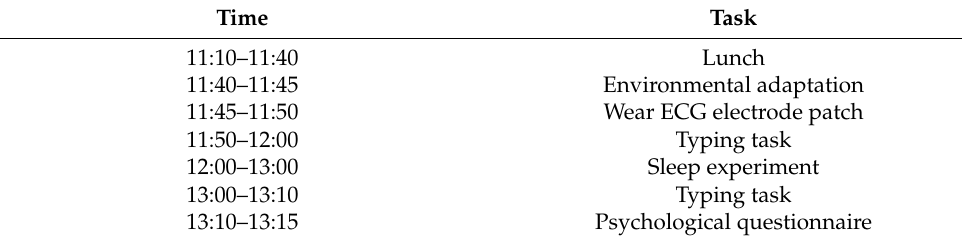
Table 1. Experimental